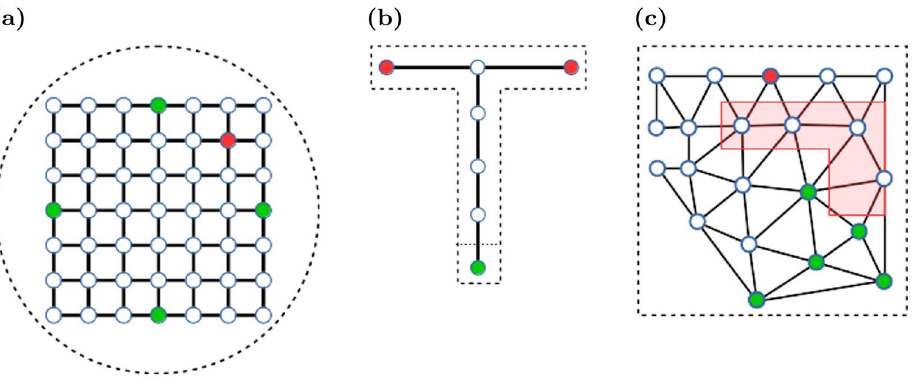
Figure 3. Topology graphs for different simulation environments. ( a ) Morris watermaze. ( b ) T-maze. ( c ) Shock zone maze. The red polygon indicates the shock zone. Nodes in the graph indicate allowed positions, and solid lines allowed transitions between positions. Start nodes are marked green, and (potential) goal nodes are marked red. The dashed lines sketch the maze